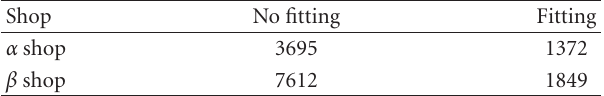
Table 12: RFID data